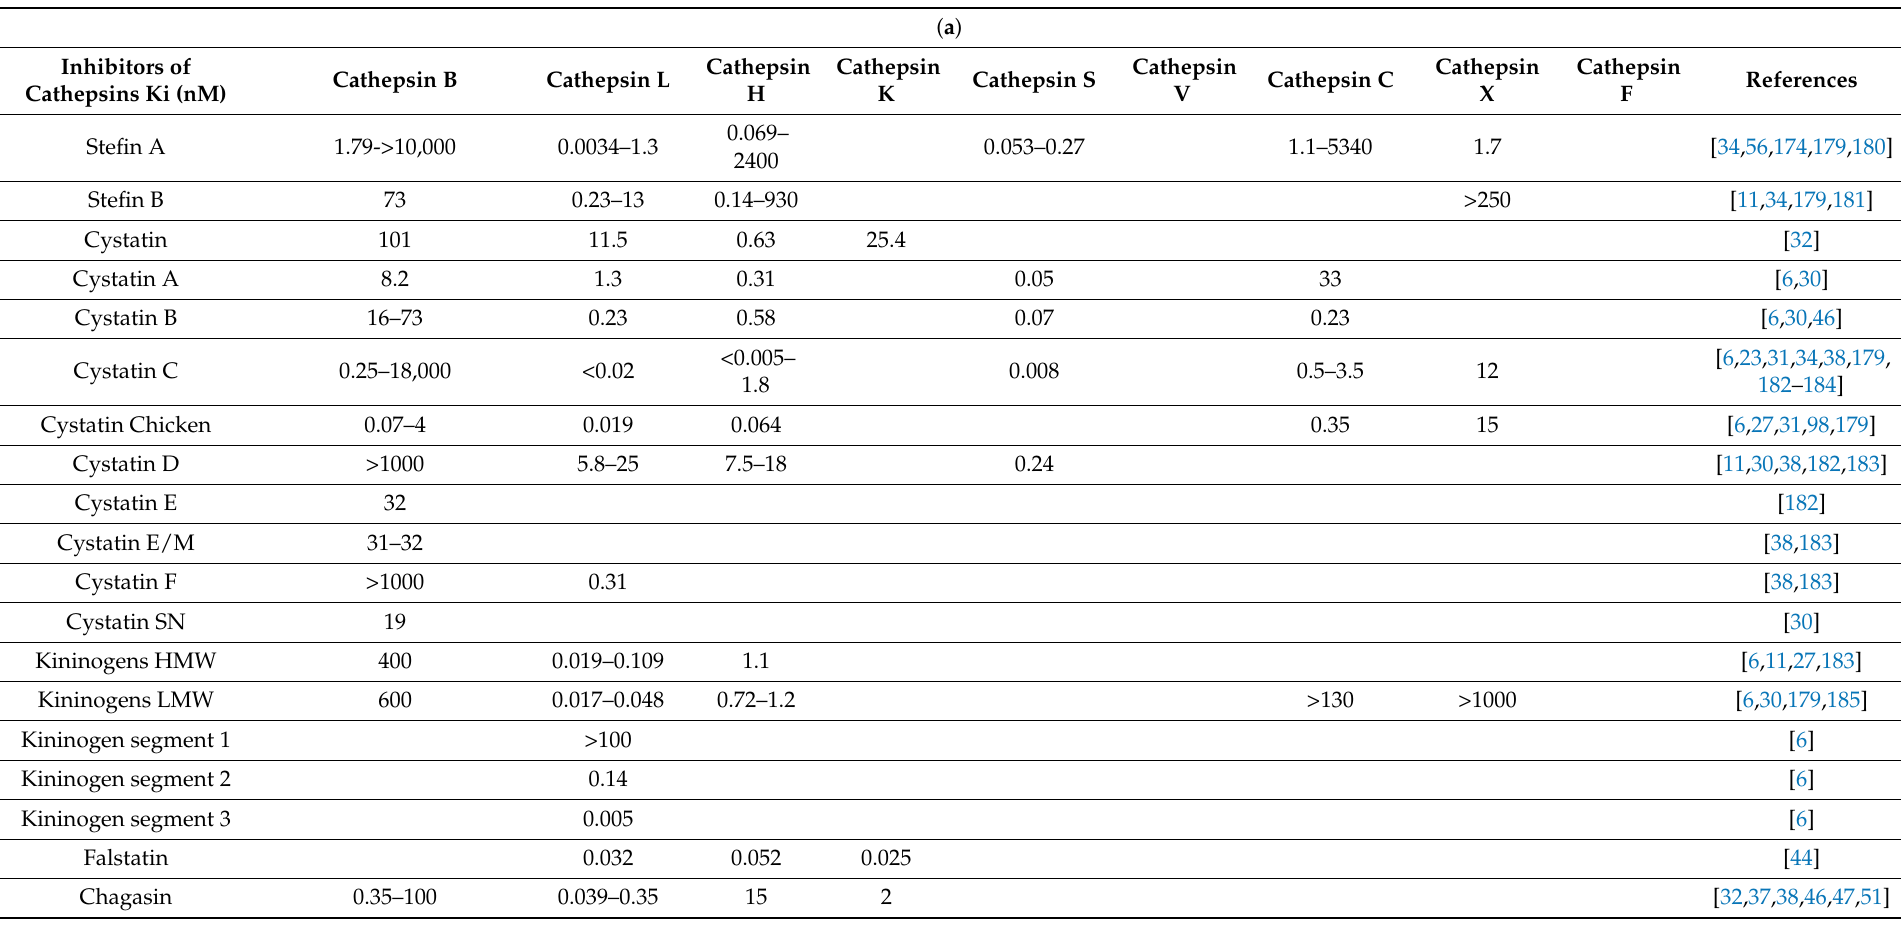
Table A1. Compiled kinetic constants Ki for the comparison of inhibitors potency presented as ranges of values reported by the researchers in the publications. ( a ) Ranges of binding constants for cathepsin inhibitors Ki (nM). ( b ) Range of binding constants for caspase inhibitors Ki (nM). ( c ) Ranges of binding constants for papain and similar protease inhibitors Ki (nM). ( d ) Ranges of binding constants for the small group of protease inhibitors Ki